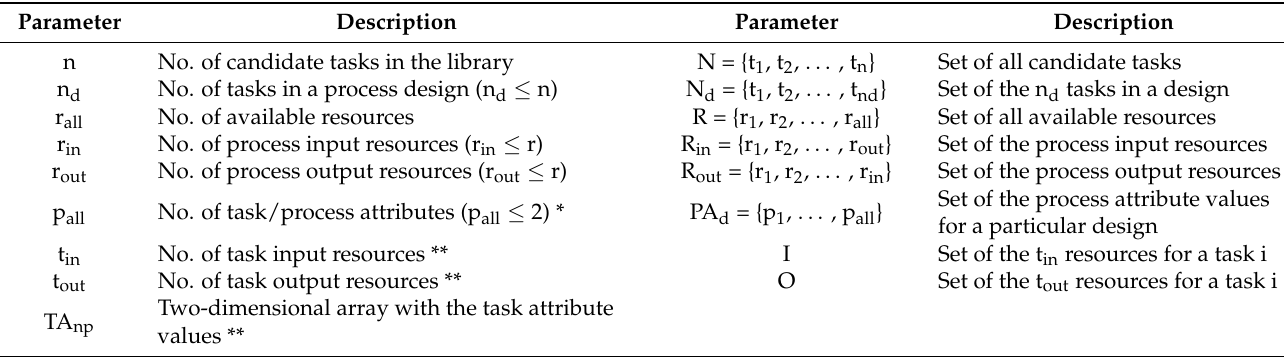
Table 1. Parameters of the business process design composition and optimization problem as presented in [5]. Parameter Description Parameter